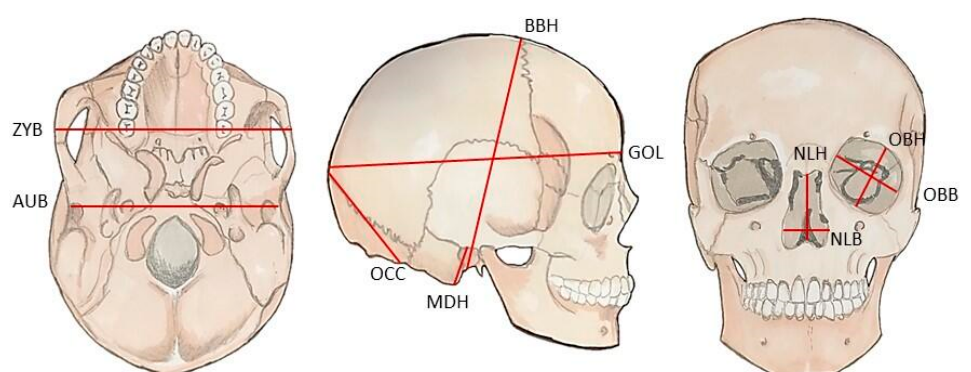
vided in Table 1. (ZYB: bizygomatic breadth; MDH: mastoid height; AUB: biauricular breadth; OBH: orbit height; GOL: glabella-occipital length; NLB: nasal breadth; OCC: lambda-opisthion chord; OBB: orbit breadth; BBH: basion-bregma height; NLH: nasal height).